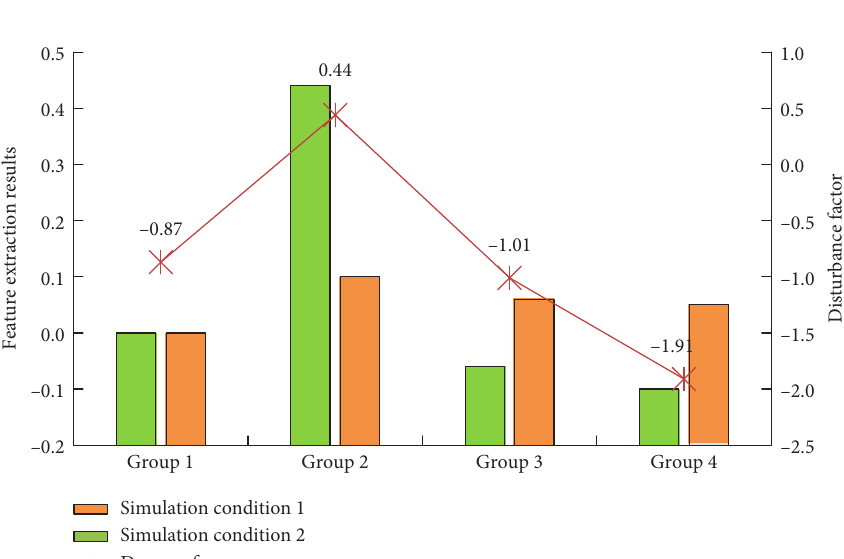
Figure 6: The result of data processing under this model.